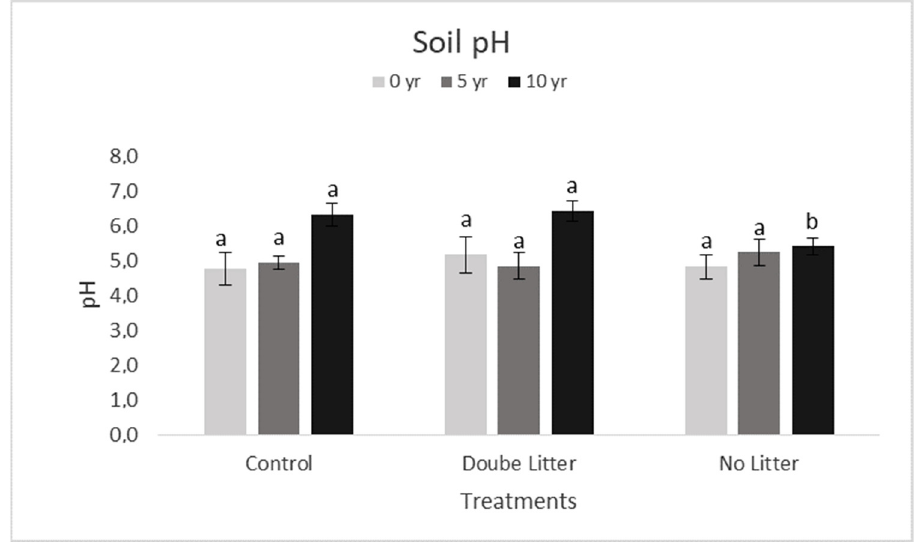
Figure 2. Soil pH at the start of the treatments and after 5 and 10 years, based on spring measurements (average of 6 samples per treatment; letters indicate the significant difference between treatments within the same sampling time).